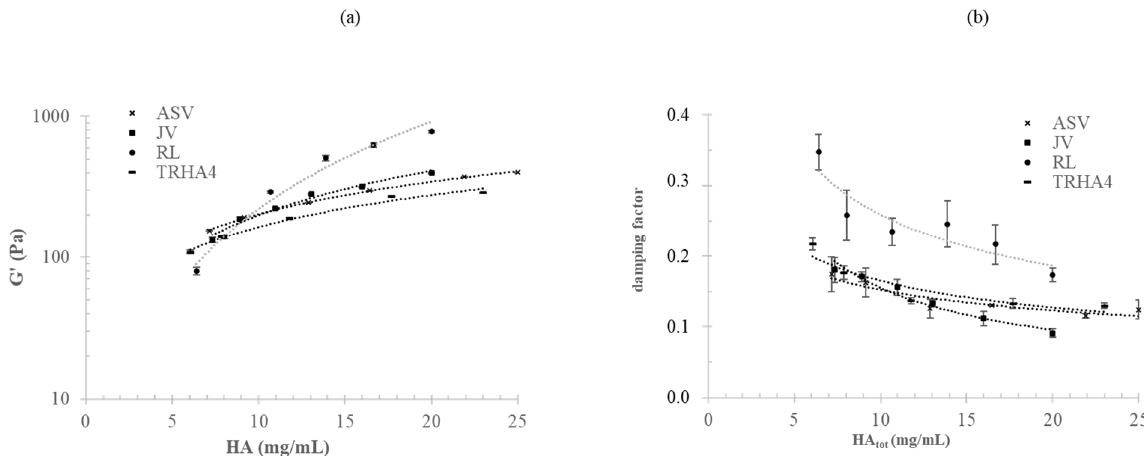
Figure 4. Variation of the rheological parameters of the gels while hydrating. The G ′ ( a ) and tan delta ( b ) values measured for the gels with increasing dilution in a physiological medium are plot- ted as a function of HA concentration.